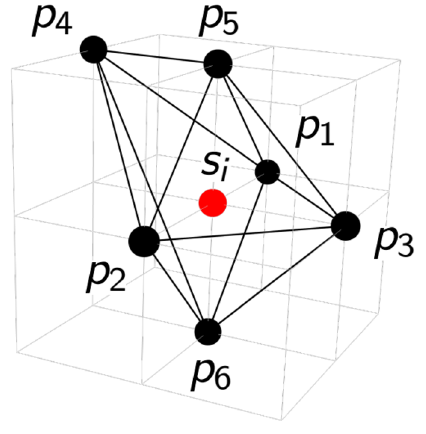
Figure 31 . Toric diagram for Model